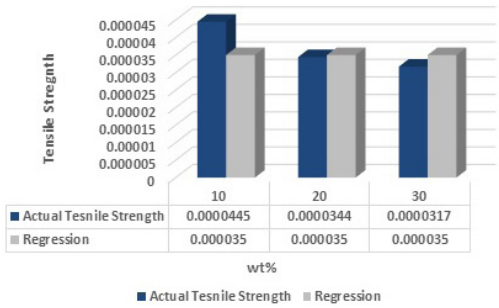
Figure 11. A comparison between the regression equation and the actual value of the tensile strength of untreated sisal-PP